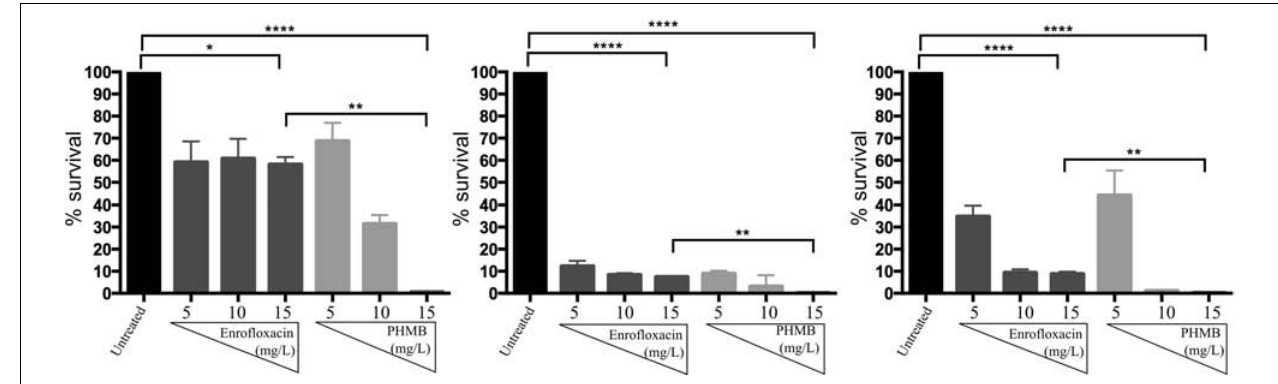
FIGURE 4 | Bactericidal activities of enrofloxacin and PHMB against intracellular S. aureus 15 AL, 59, and 204. Mac-T cells infected with S. aureus strain 15 AL, 59, or 204 were either untreated or treated with increasing concentrations of enrofloxacin or PHMB. Untreated cultures were used to establish cfu values corresponding to 100% survival.